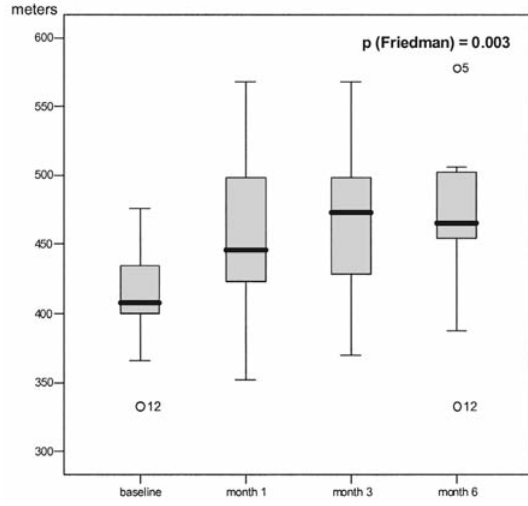
Six minute walk dis- tance during different time points of a six month treatment pe- riod with